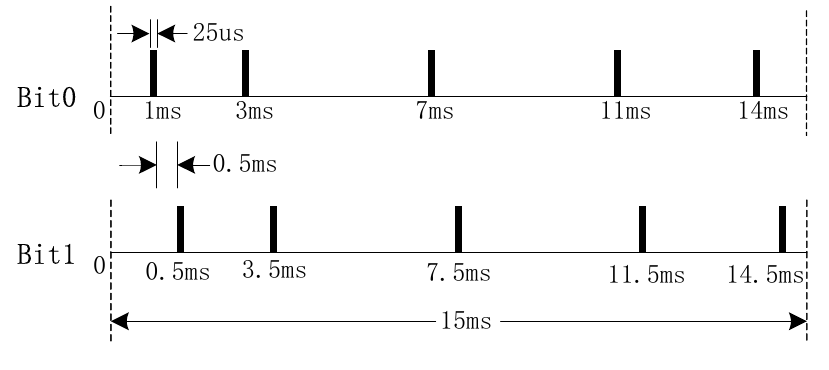
Figure 1. Coding format.